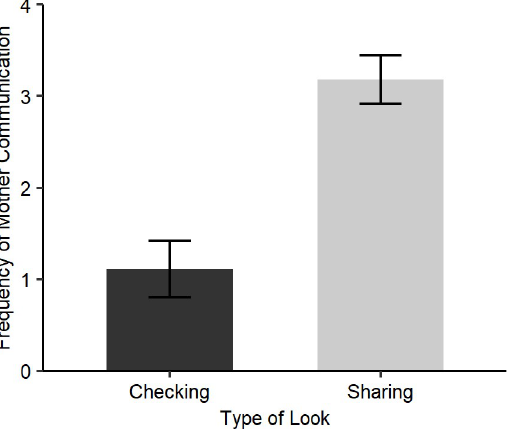
Fig 2. Mean frequency of mother communication in high agreement looks rated by the majority of participants as “Checking looks” and “Sharing looks”, with SEM error bars.